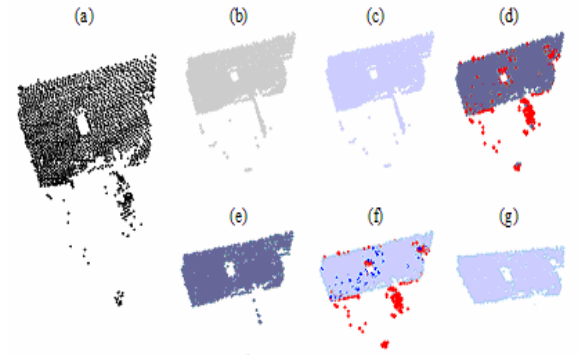
Figure 6. (a) Real point cloud data (b) LS plane (c) PCA plane (d) outliers (red points) detected by RANSAC (e) RANSAC plane (f) red and blue points (outliers) detected by RD and OD respectively (g) DRPCA plane